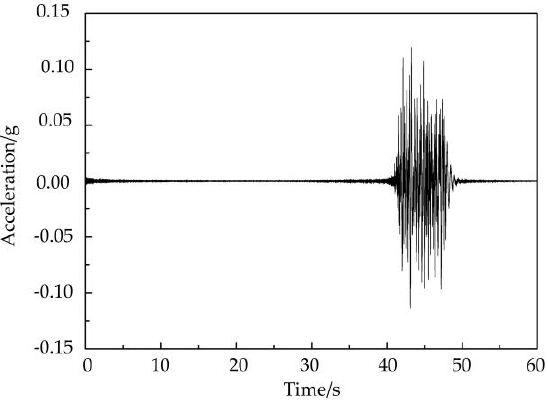
Figure 9. Typical vertical acceleration of Segment 1 in the current monitoring stage.